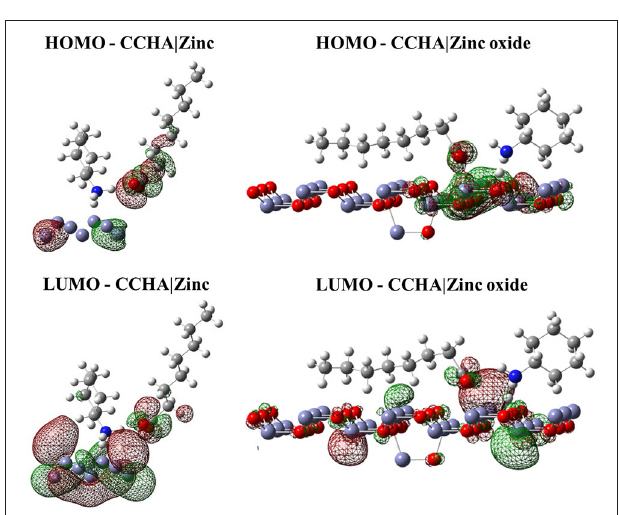
FIGURE 2 | Isodensity surfaces (density value = 0.0001 A − 3 ) of HOMO and LUMO orbitals of CCHA molecule with the zinc and zinc oxide surfaces. The red color represents the negative part of the wave function and the green color corresponds to the positive